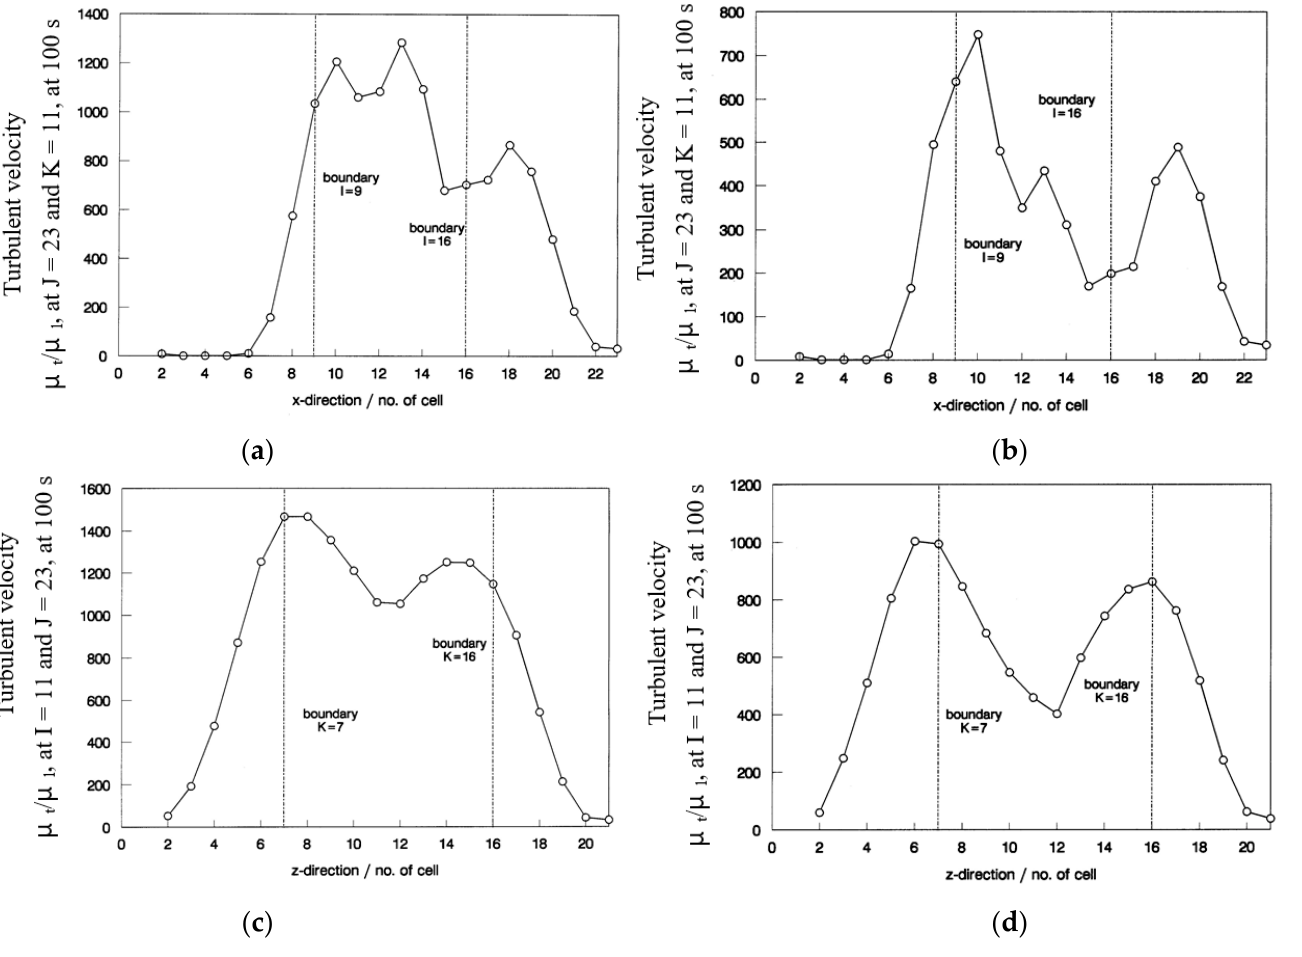
Figure 7. Predicted turbulent viscosity variation: ( a ) Tu 2 (boundary at I = 9 and I = 16); ( b ) Tu 3 (boundary at I = 9 and I = 16); ( c ) Tu 2 (boundary at K = 7 and K = 16); and ( d ) Tu 3 (boundary at K = 7 and K = 16).